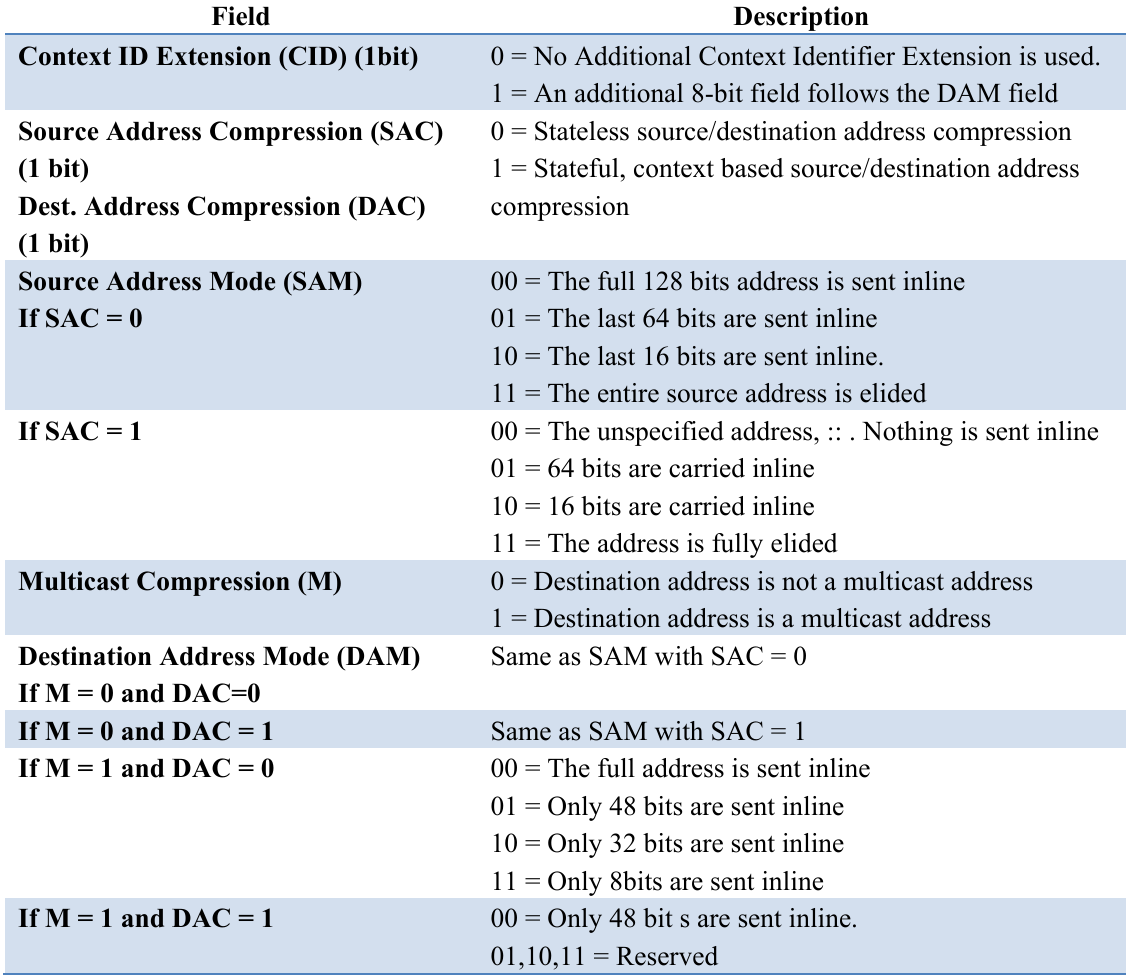
Table 2. Summary of Dispatch Byte